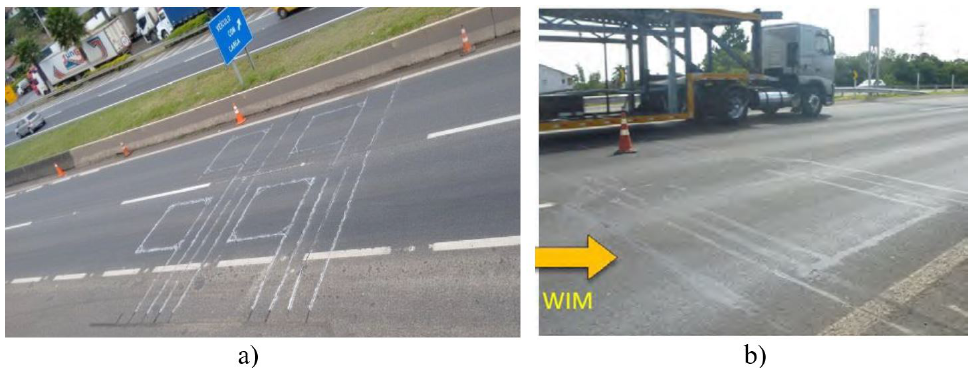
Figure 6. Final appearance of HS-WIM system in both highways: a) BR-381 [15]; b) BR-290 [16].